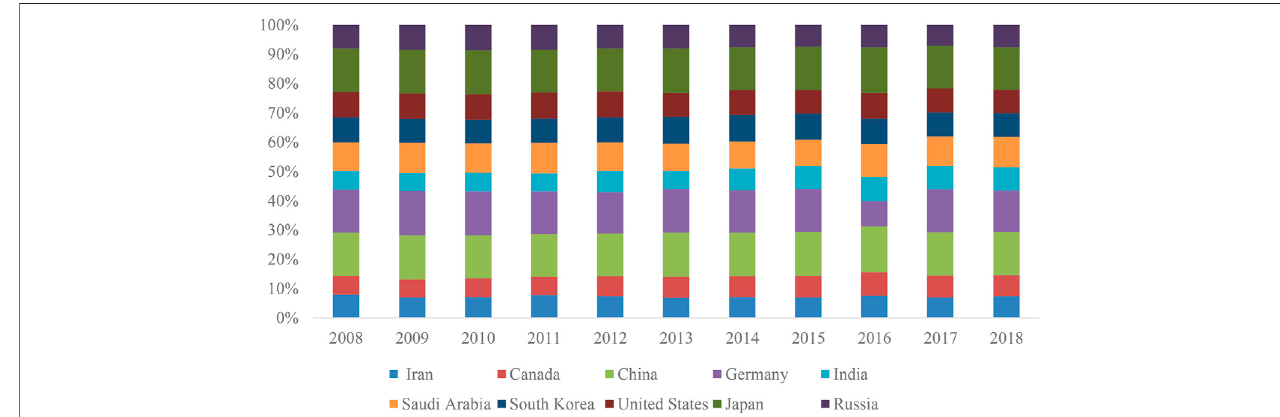
FIGURE 2 | Environmental ef fi ciency score.